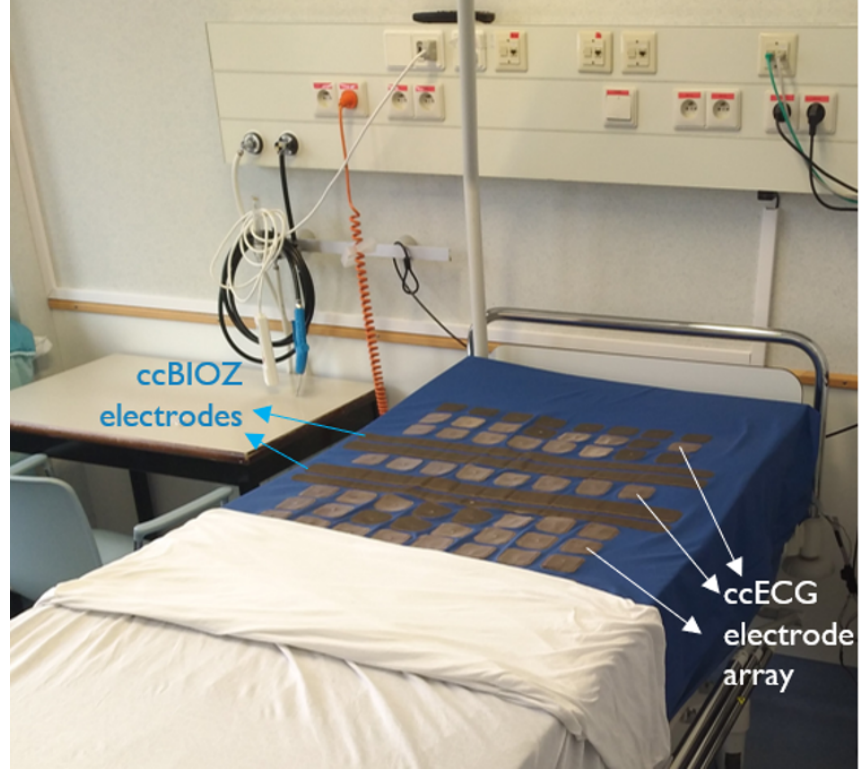
Figure 1. Mattress with integrated capacitively-coupled sensors for acquisition of ccECG and